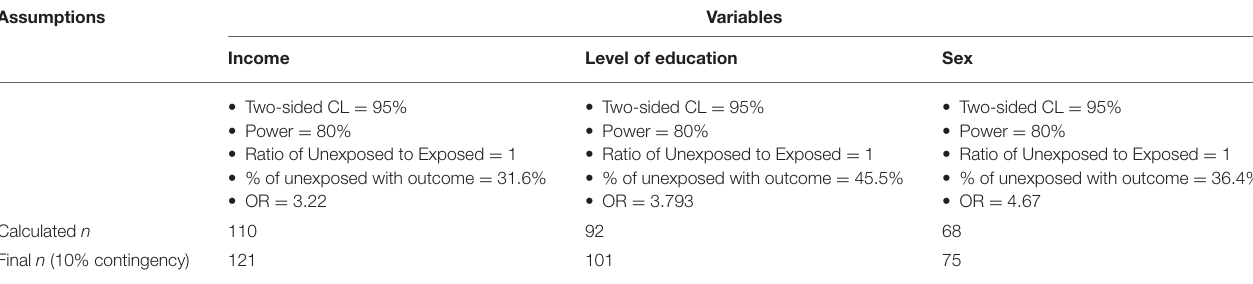
TABLE 1 | Calculated sample size for factors using two populations proportions by Open Epi version 7.